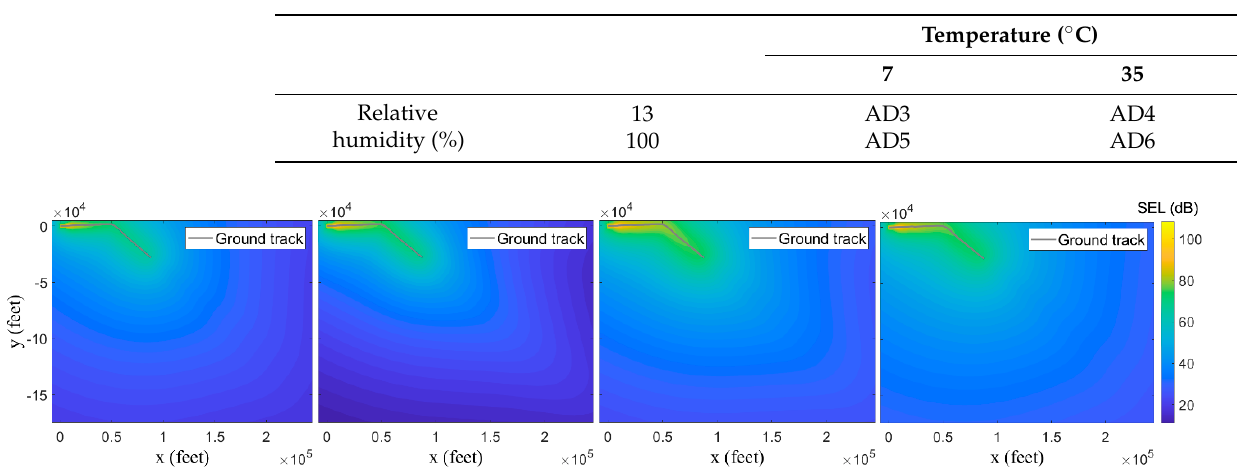
Figure 16. A330 aircraft departing from HKIA. Aircraft noise impact on the ground, as depicted in terms of SEL for cases AD3, AD4, AD5, AD6 (from left to right, respectively).